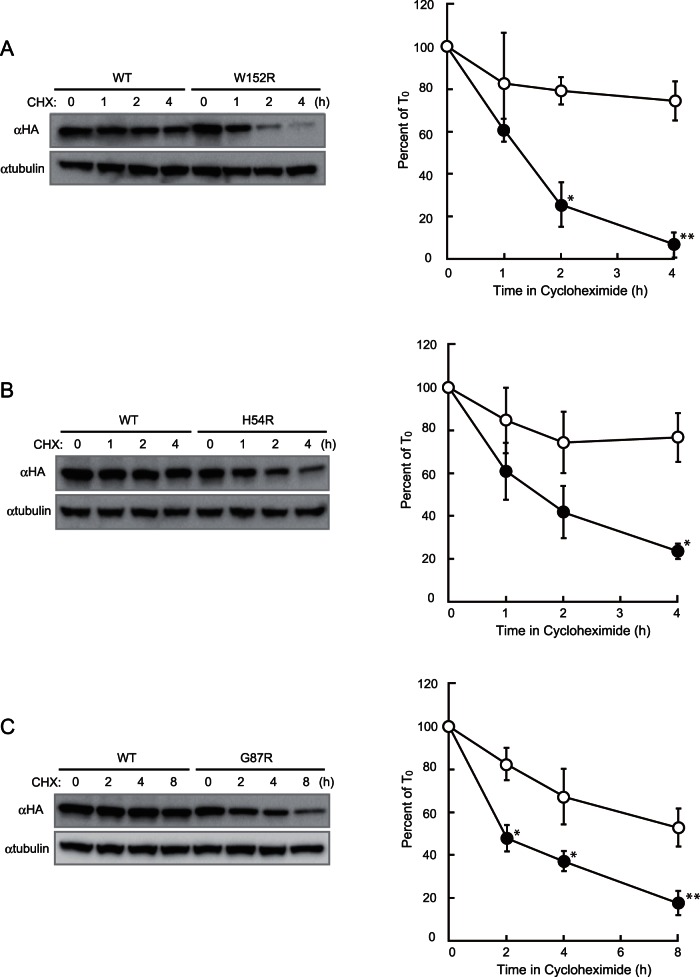
Protein stability of W152R, H54R and G87R hZnT2 mutants.The expression levels of the WT (○) and W152R (•) mutant hZnT2 proteins (A), the WT (○) and H54R (•) mutant hZnT2 proteins (B), and the WT (○) and G87R (•) mutant hZnT2 proteins (C) at each time point. Immunoblot analysis was performed to monitor hZnT2 levels (left panel), as described in Figure 6. In the right panels of (A) – (C), each value is the mean ± SD of triplicate experiments. The same membrane was used for detection of both hZnT2 and tubulin. Tubulin is shown as a loading control. * and ** denote a significant difference between expression levels of the WT and W152R, H54R or G87R mutant hZnT2 at each time point (* P<0.05, ** P<0.01).